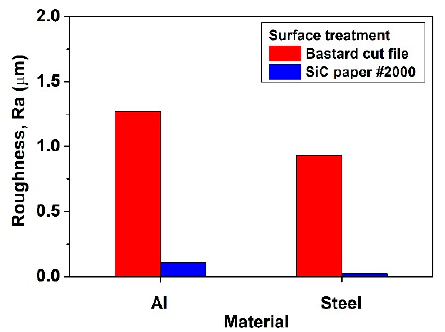
Figure 5. Surface roughnesses of the steel and aluminum. Table 3. Surface roughness of steel and aluminum (the Ra values are shown in µ m). Steel Aluminum Bastard cut